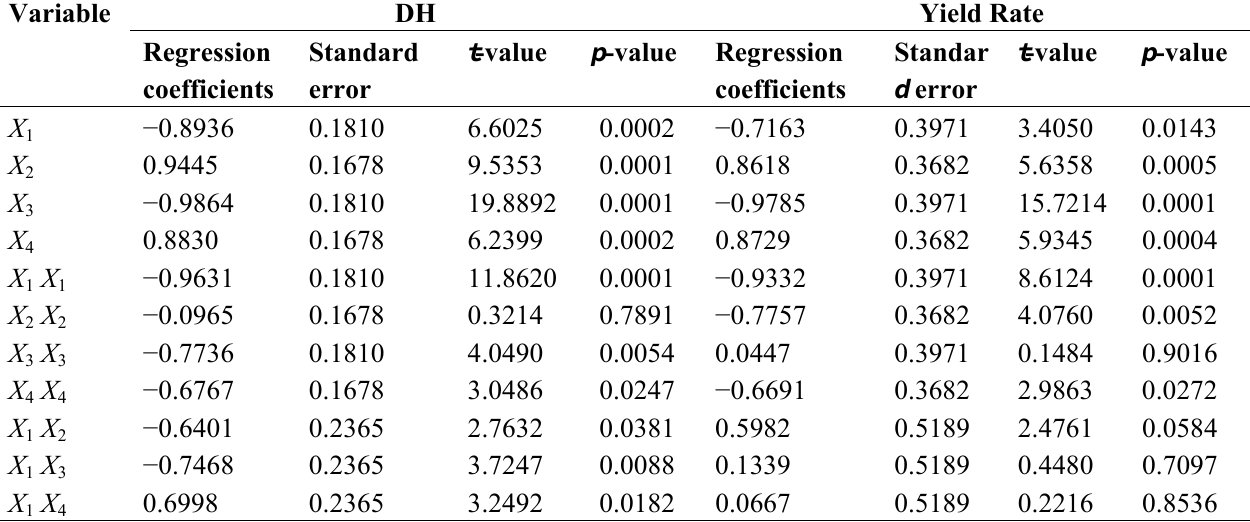
Table 3. Significance of regression equation coefficients for the DH and AOP yield